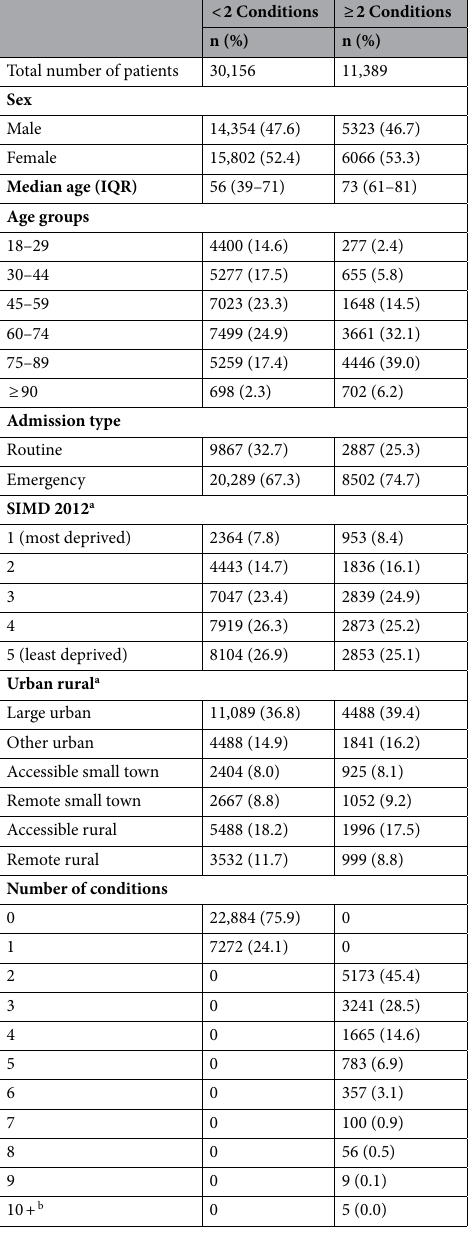
Table 1. Baseline characteristics and counts of conditions. IQR, inter-quartile range; SIMD, Scottish Index of Multiple Deprivation. a 314 patients had missing values for SIMD category (< 2 n = 279, ≥ 2 n = 35) and 576 patients had missing values for Urban Rural category (< 2 n = 488, ≥ 2 n = 88). b Rows reporting number of patients with 10 and 11 conditions have been collapsed due to counts <